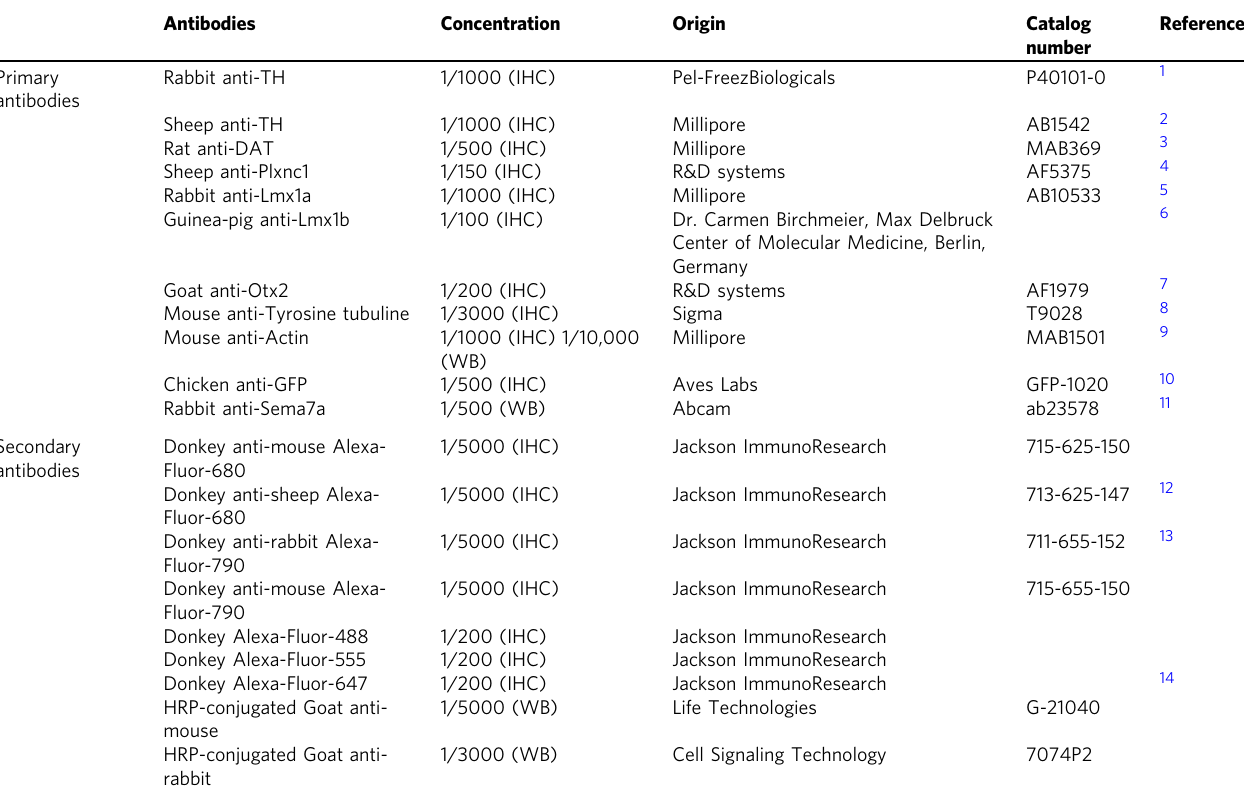
Table 1 Antibodies used for this study Antibodies Concentration